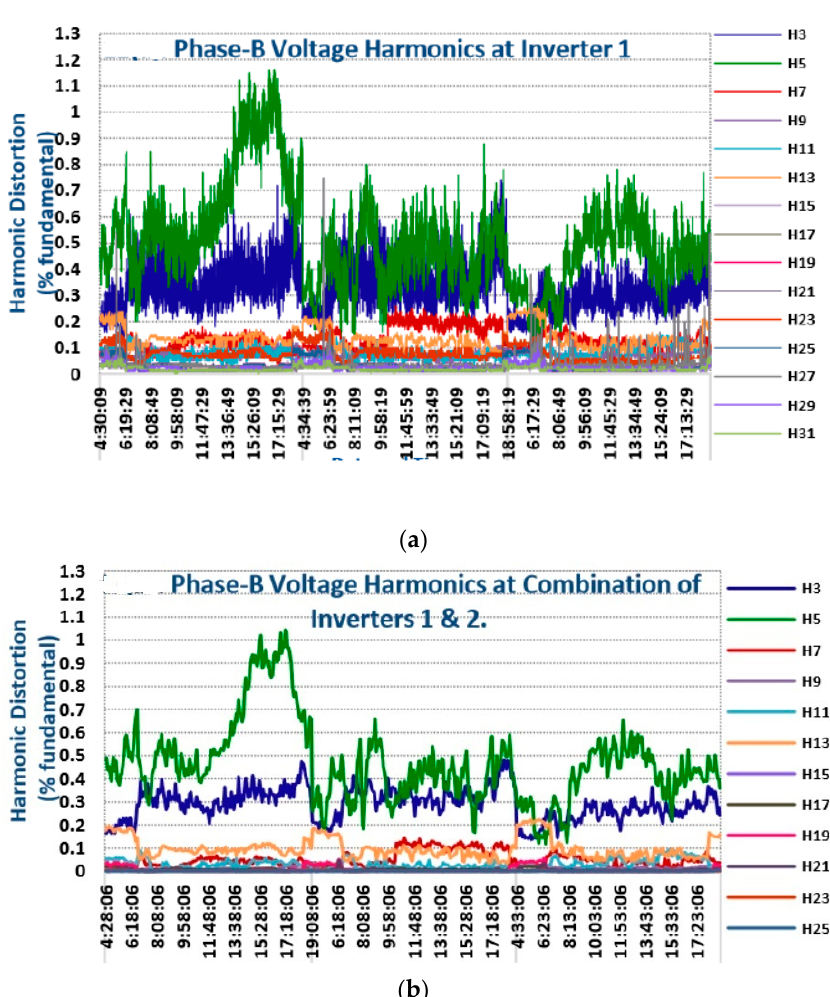
Figure 2. individual voltage harmonics of phase B at ( a ) PVDG, ( b ) BESS outputs [31]. Figure 2. Individual voltage harmonics of phase B at ( a ) PVDG, ( b ) BESS outputs [31].